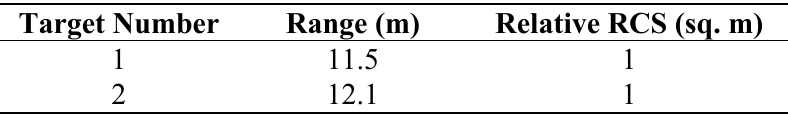
Table 4. Target Scenario